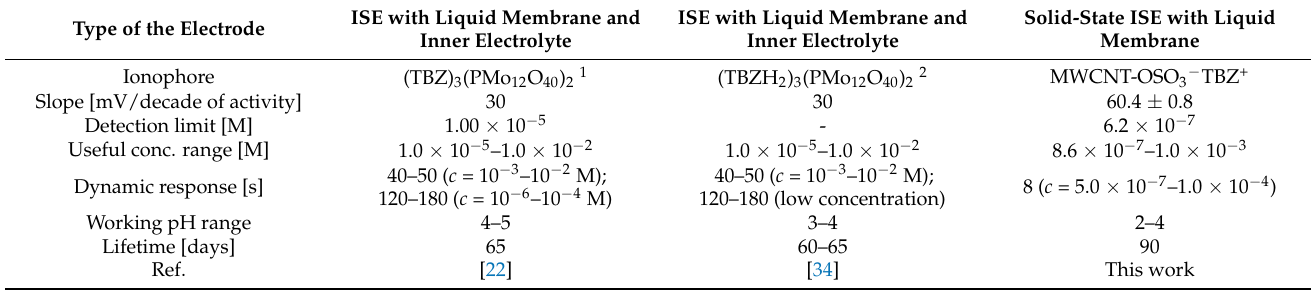
Table 2. The comparison of the performance of the new MWCNT-OSO 3- TBZ + sensor with the per- formance of other potentiometric sensors for TBZ determination.